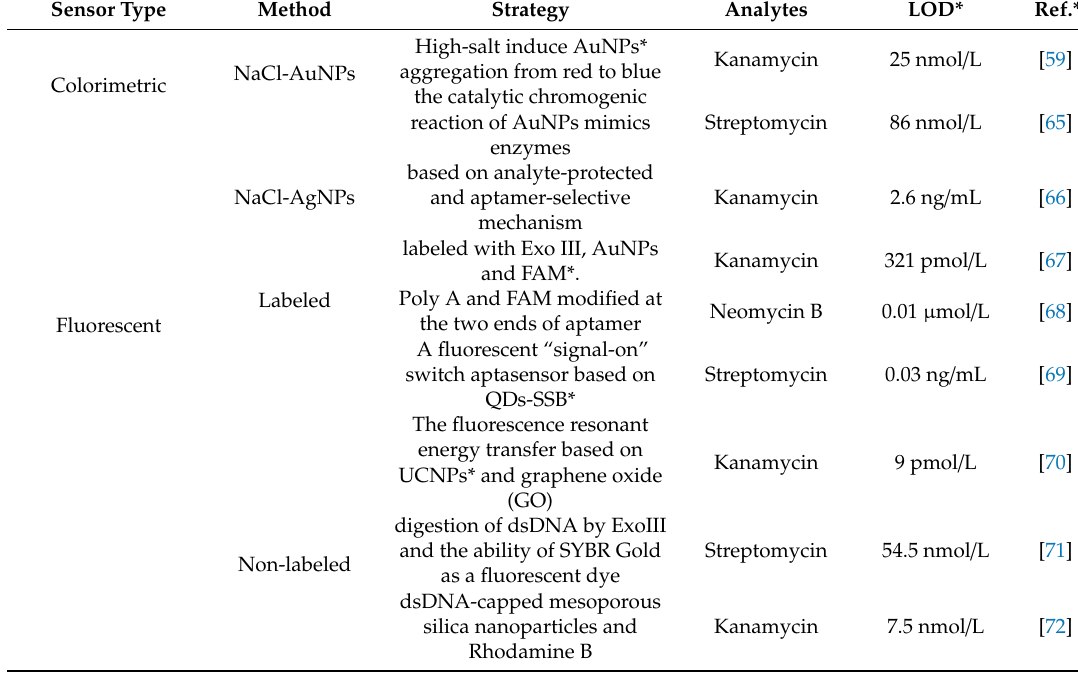
Table 3. Summary of aptasensor types, detection methods, and